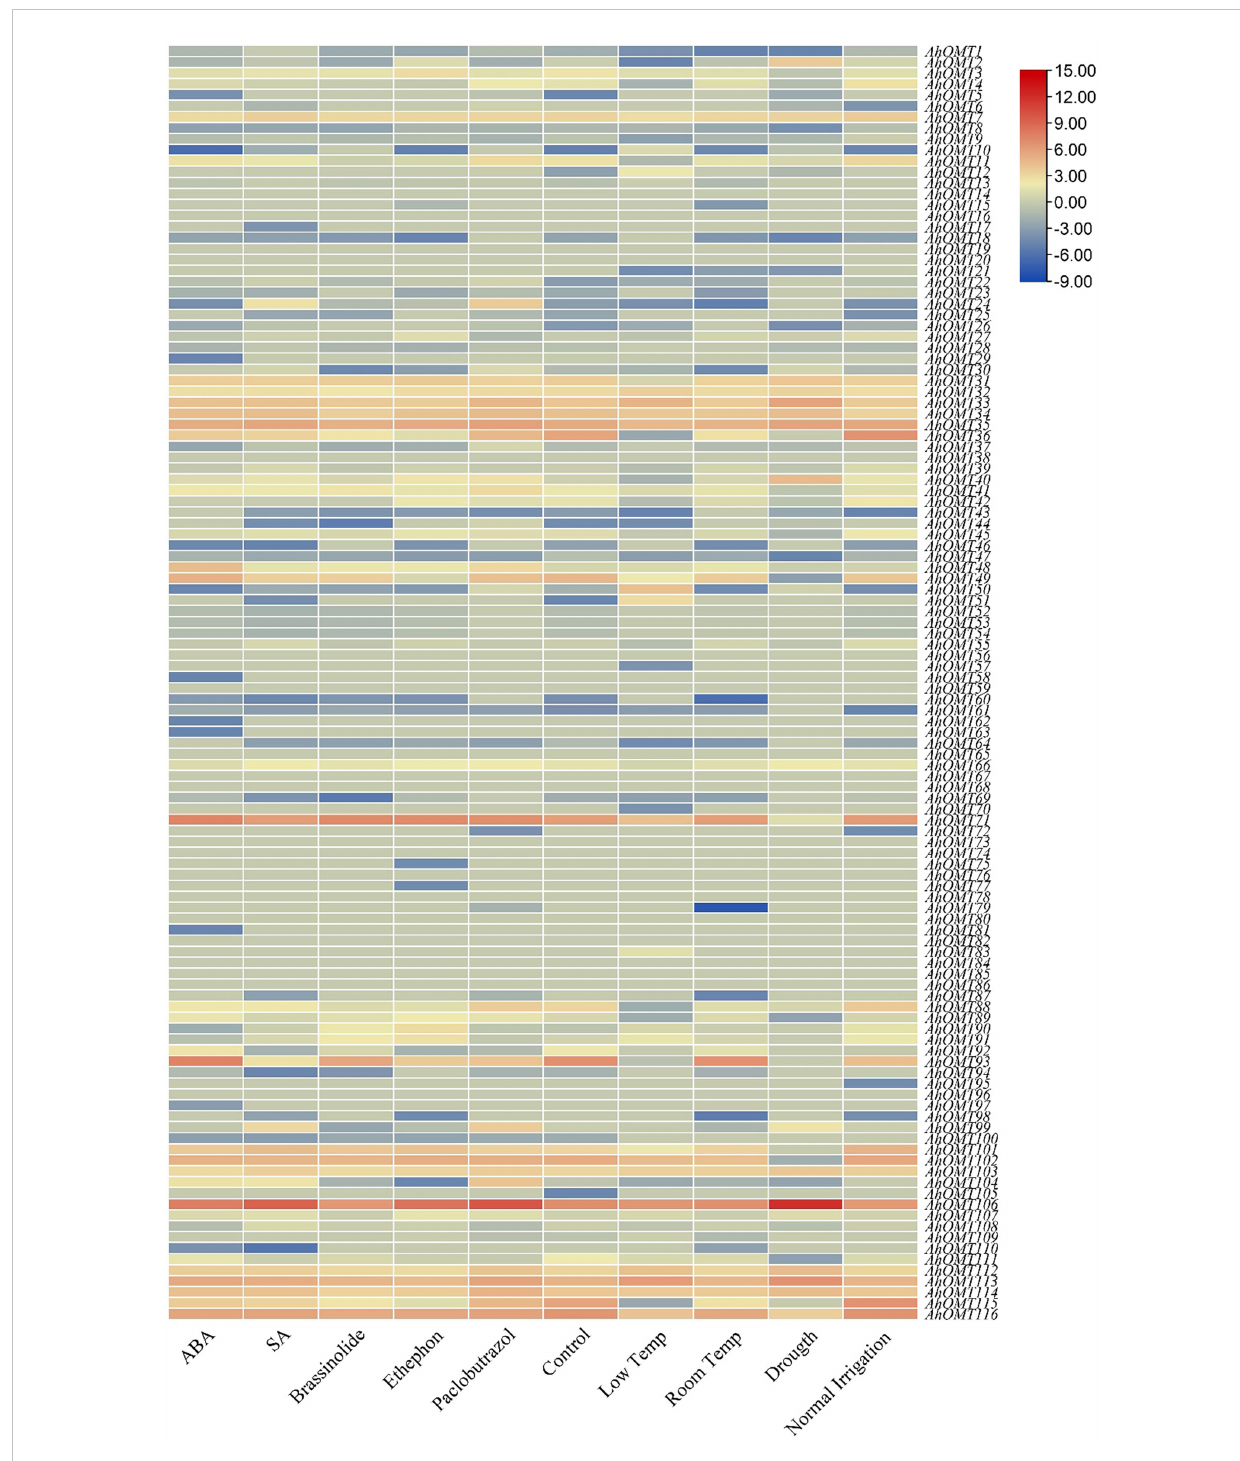
FIGURE 13 Transcriptome expression of AhOMTs under different hormones and stress conditions. Under the stress conditions, the AhOMT106 gene was most active, while AhOMT35 , AhOMT71 , AhOMT113 were also expressed in most of